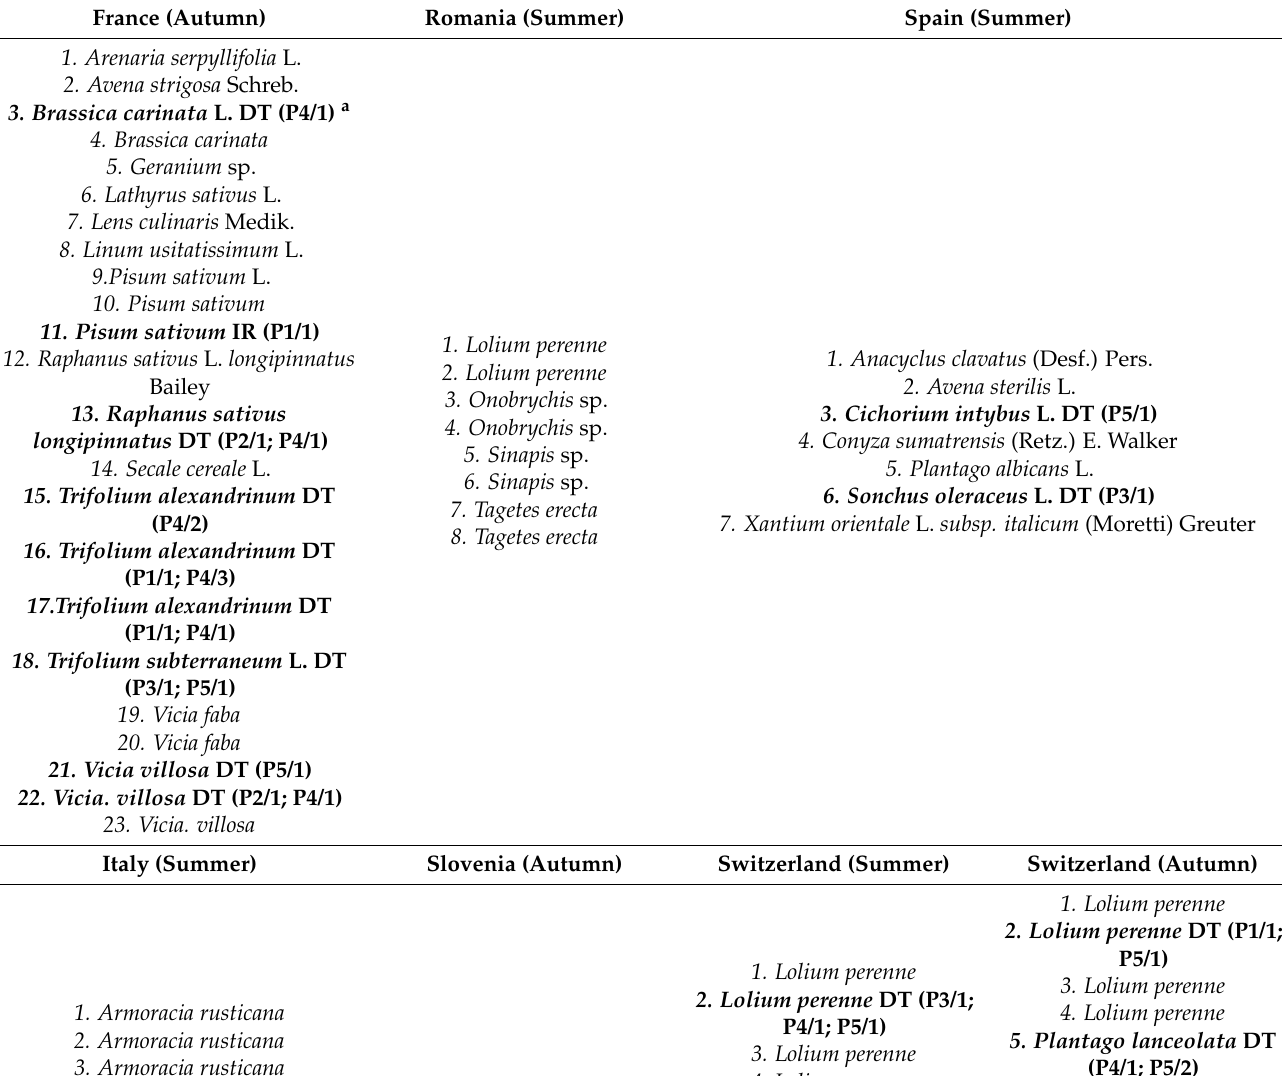
Table 3. Eighty-one samples of the planted and native cover crop species collected in experimental vineyards in six European countries in 2020, with indications of the Cylindrocarpon -like asexual morphs isolated from their